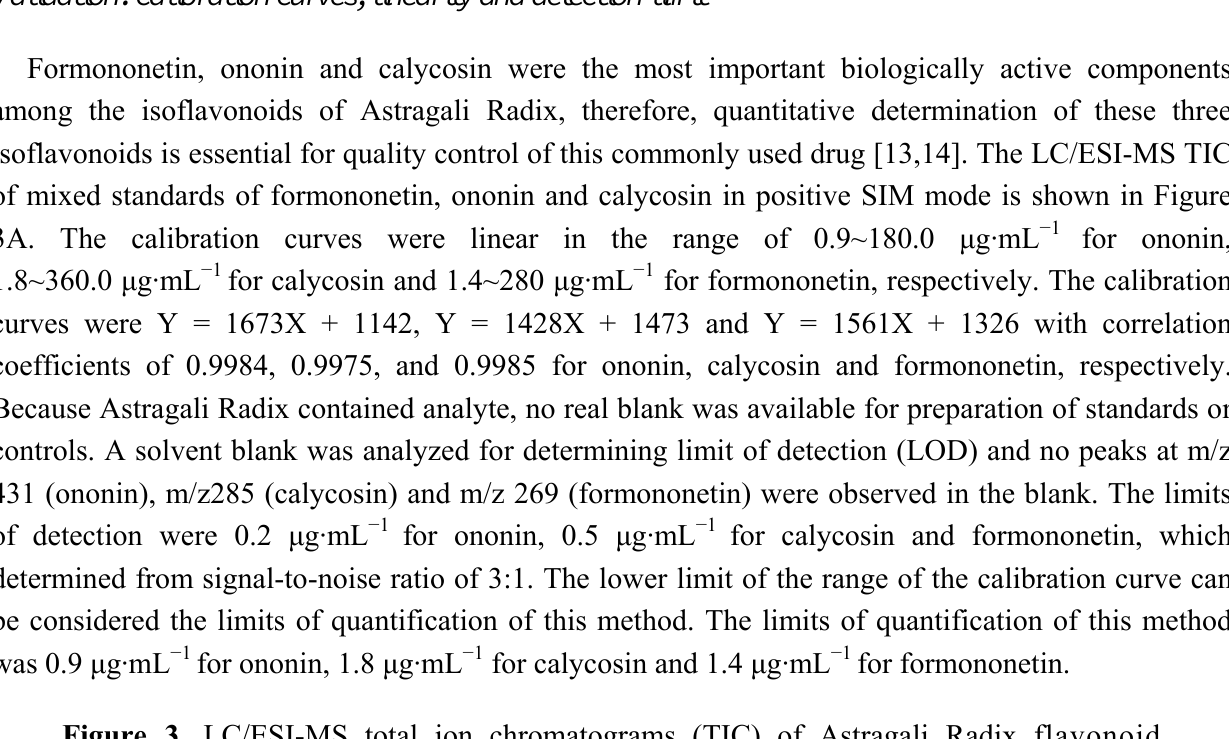
Figure 3. LC/ESI-MS total ion chromatograms (TIC) of Astragali Radix flavonoid standards containing 60.0 μ g·mL − 1 for ononin, 40.0 μ g·mL − 1 for calycosin and formononetin (A) and A. mongholicus (B). Peaks: (1) ononin; (2) calycosin; (3)